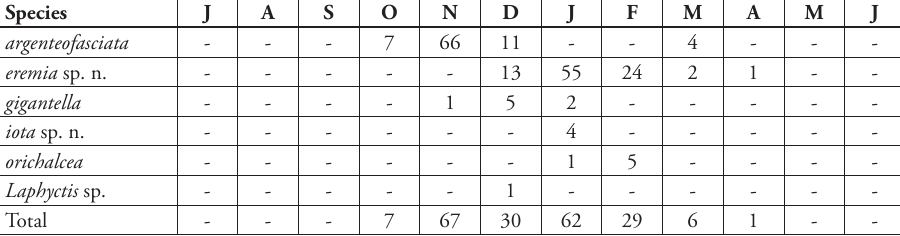
Laphyctis sp. Table 2. Phenology of Laphyctis species through number of specimens collected in each month. Months abbreviated starting with